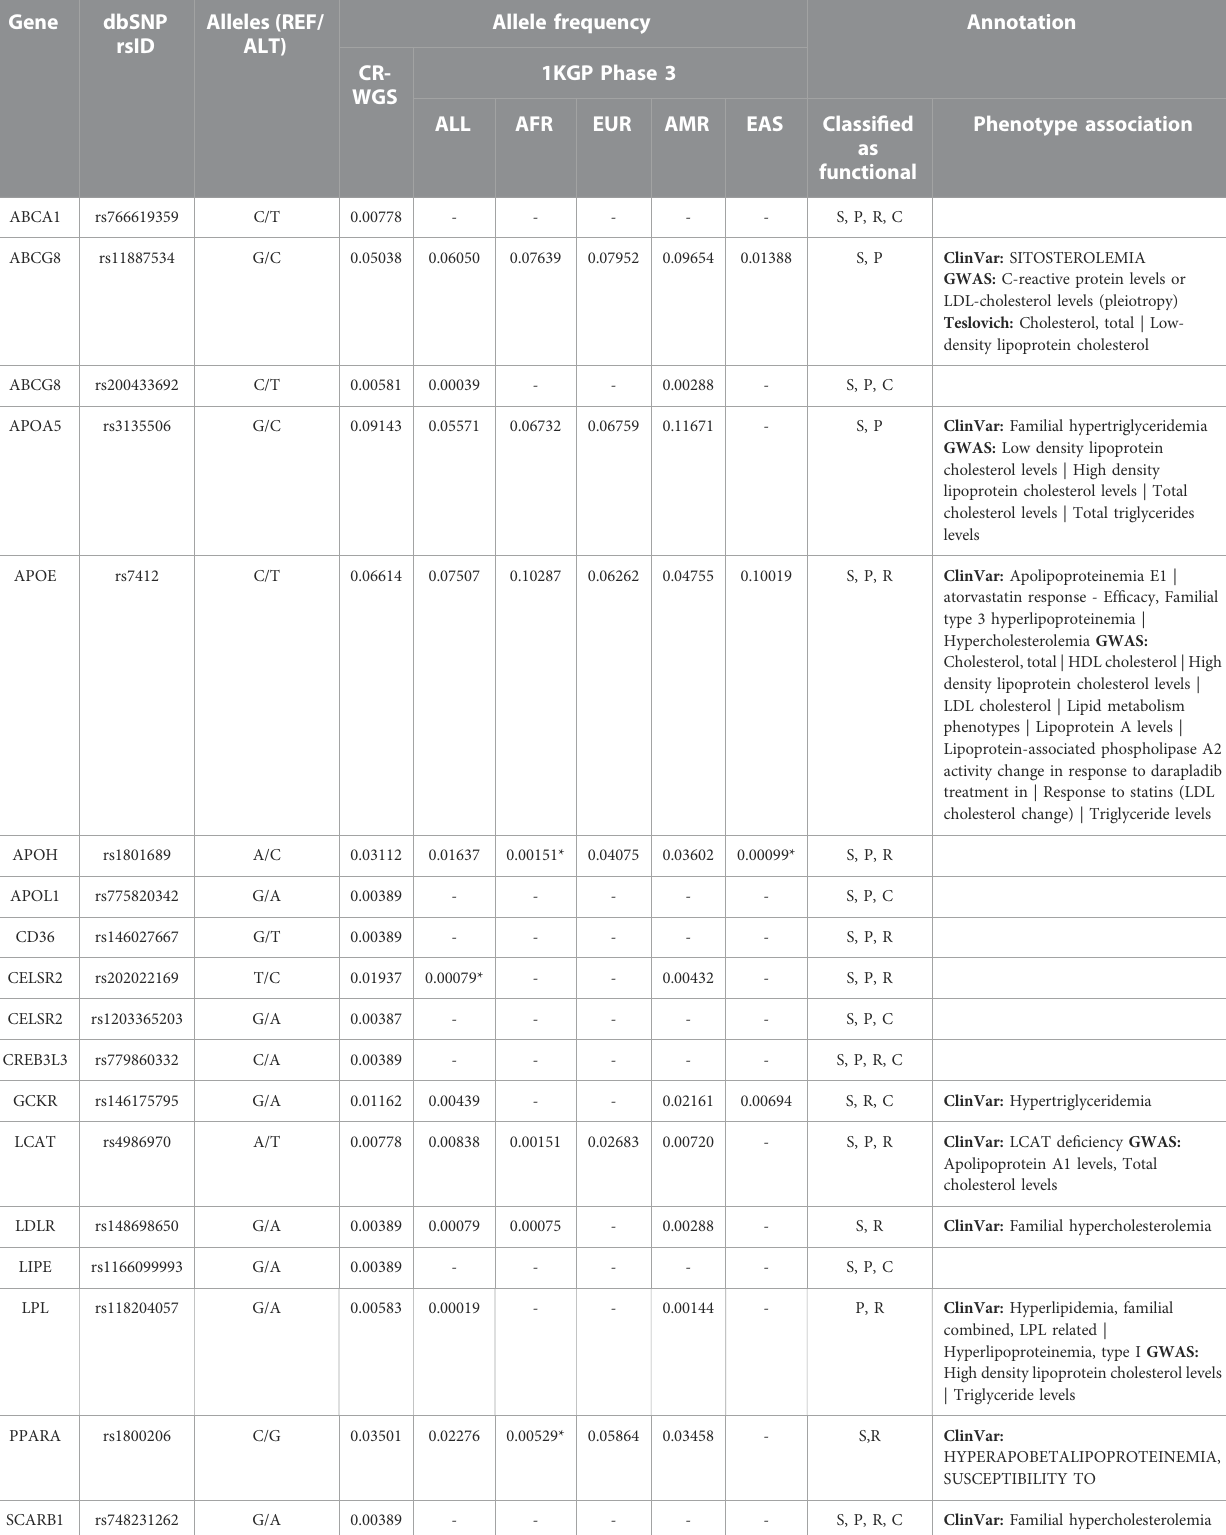
TABLE 5 Allele frequency and annotation of variants that produce alterations in genes involved in lipid metabolism that are categorized as risky by more than